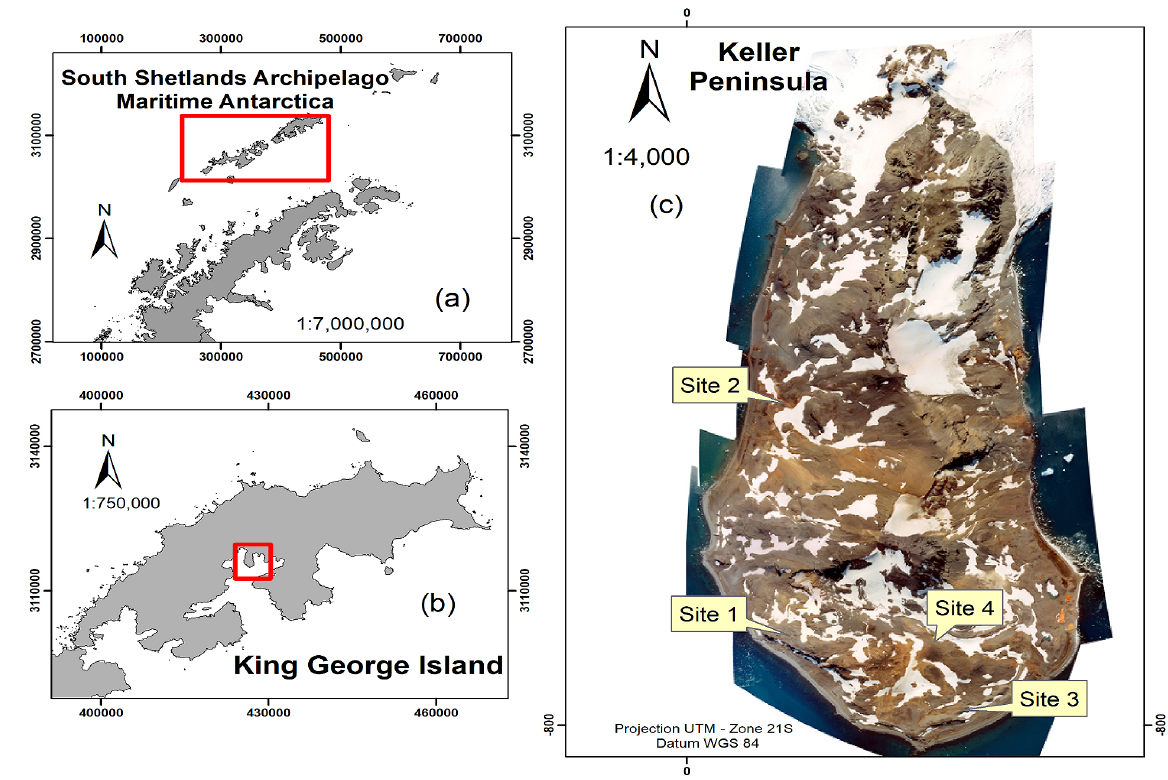
Figure 1. Schematic map showing the South Shetlands Archipelago (a) and King George Island (b), where Keller peninsula is located (c). Studied sites are shown in